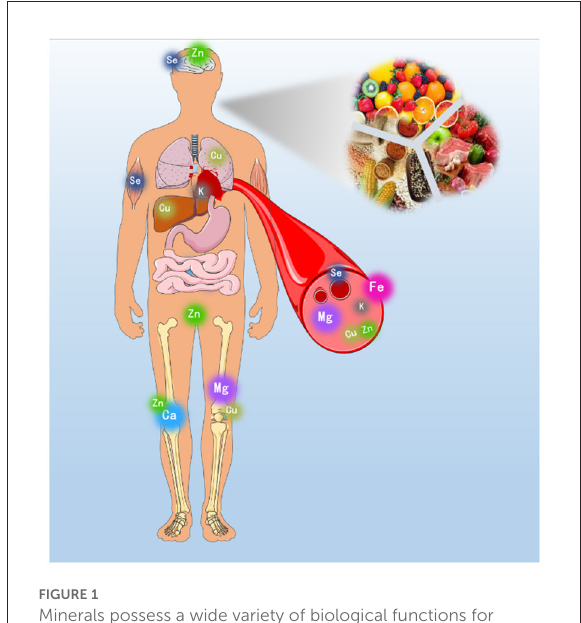
FIGURE1 Minerals possess a wide variety of biological functions for human